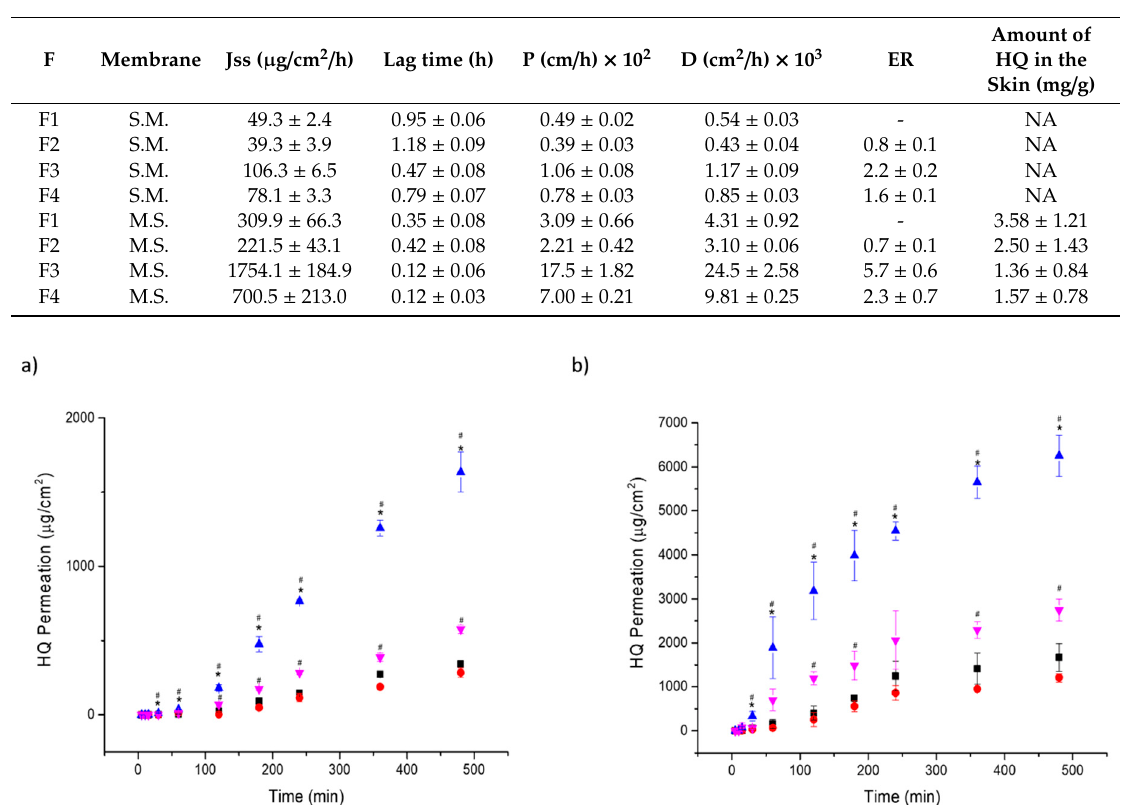
Table 4. Comparison of skin permeation of HQ formulations (F) across synthetic (S.M. for Strat-M ® ) or natural (M.S. for Mouse skin) membranes. Key: Jss, steady-state transdermal flux calculated from the slope of the Cartesian plot of the cumulative amount of the drug present in the receptor compartment versus time; ER, enhancement ratio, calculated as the ratio of steady-state transdermal flux from each formulation compared to formulation 1; P, permeability coe ffi cient calculated by using formula Jss / cd